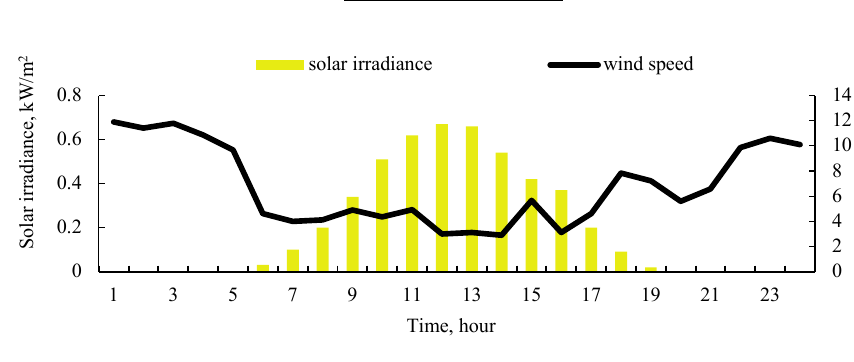
Fig. 3. Solar irradiance and wind speed at day-ahead.